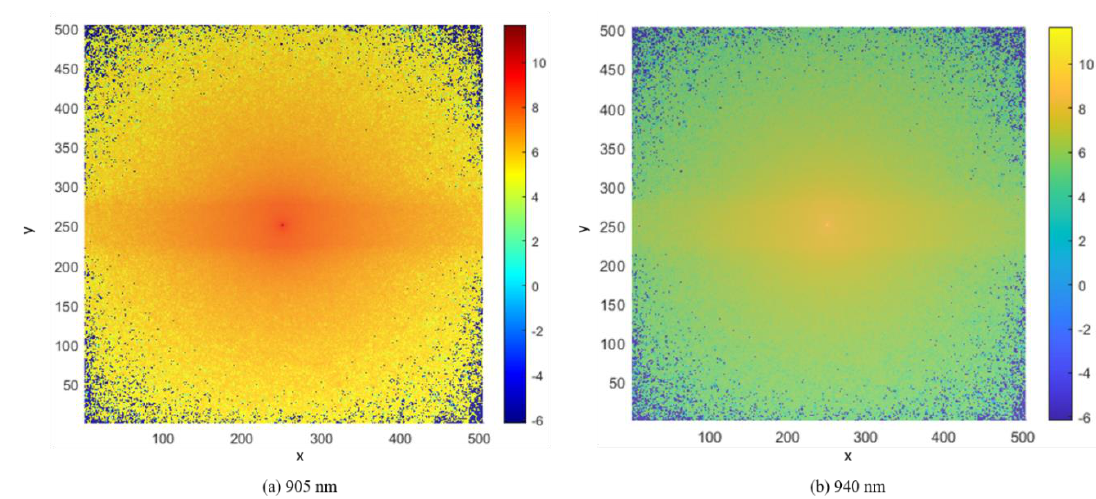
Figure 10. Photon fluence in the voxel-based finger model XY-plane view.